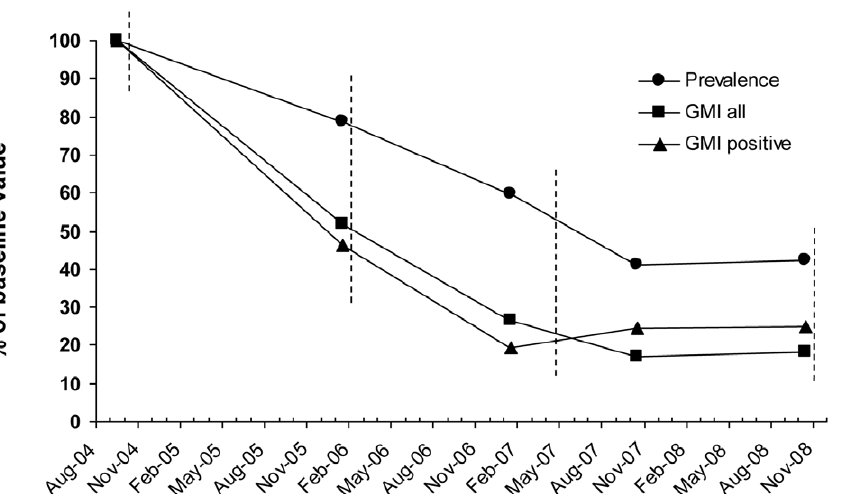
N Figure 2. The effect of three rounds of mass drug administration (MDA) on Wuchereriabancrofti microfilaemia in Kirare village. Lines ), mf geometric mean intensity (GMI) among all examined individuals ( & ) and mf GMI among positive indicate microfilaria (mf) prevalence ( individuals only ( m ). All indices are expressed in % of the baseline value. Vertical stippled lines indicate rounds of MDA.